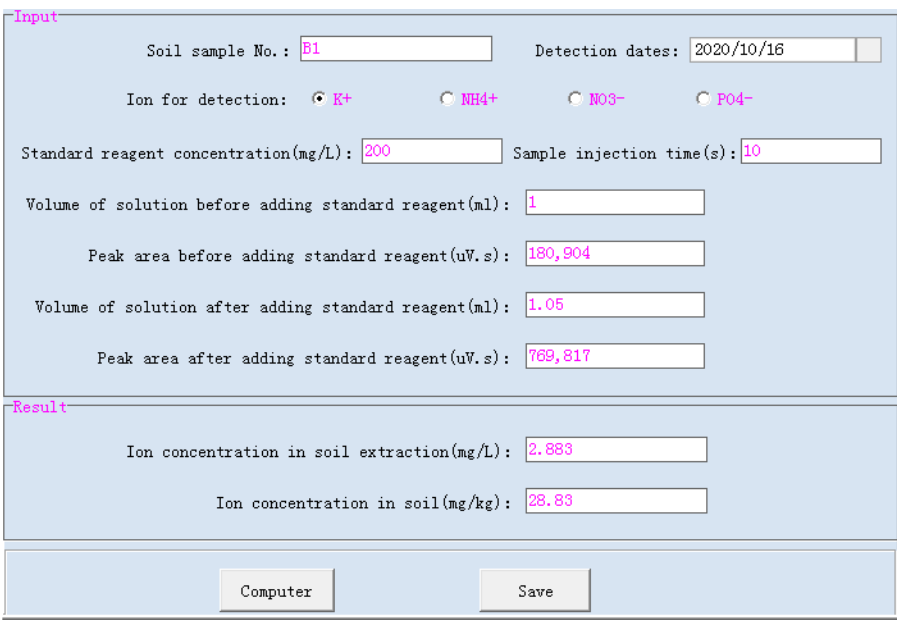
Figure 6. Quantitative calculation of ion concentration in soil.